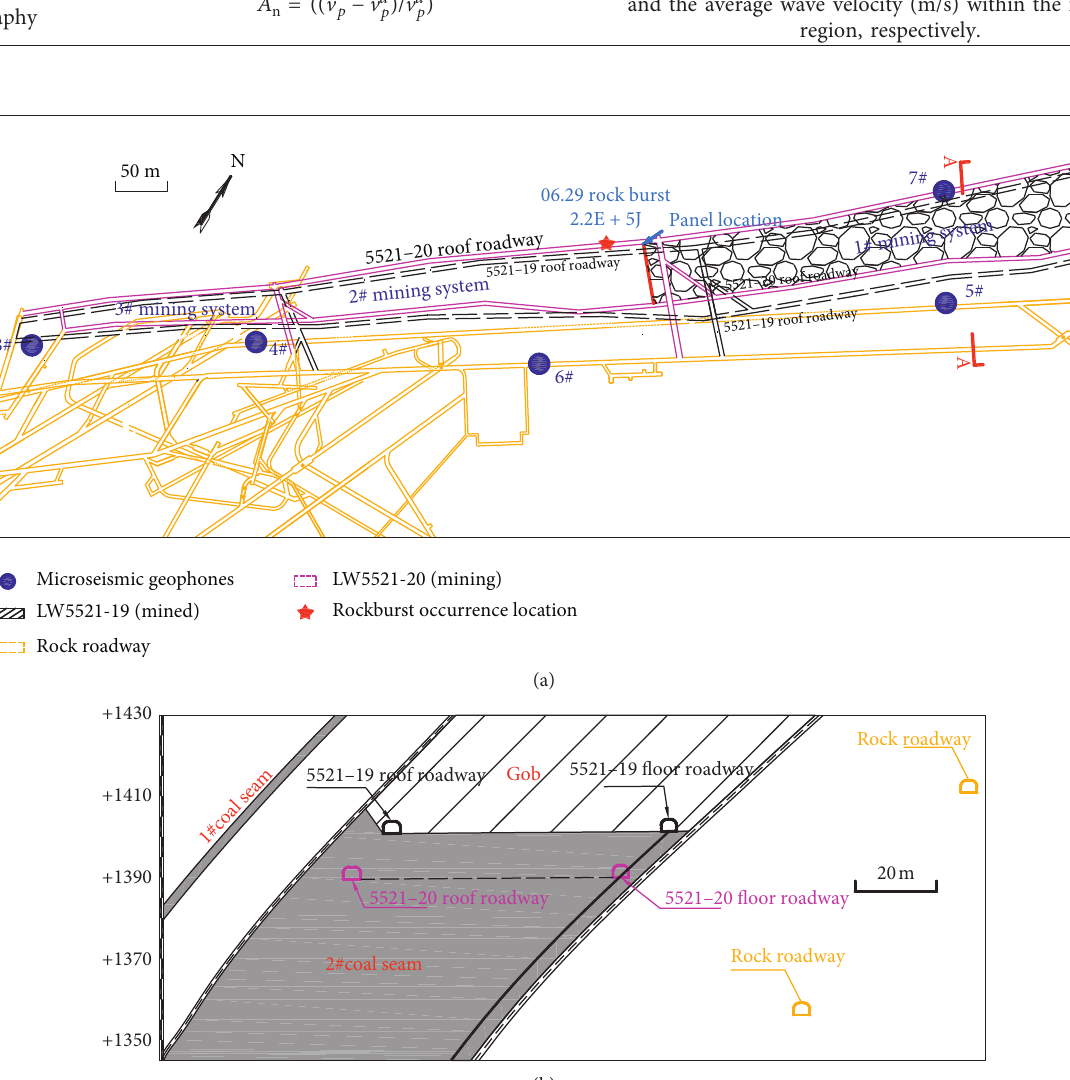
Figure 3: Layout and profile of the LW5521-20 panel. (a) Layout of the LW5521-20 panel. (b) A-A